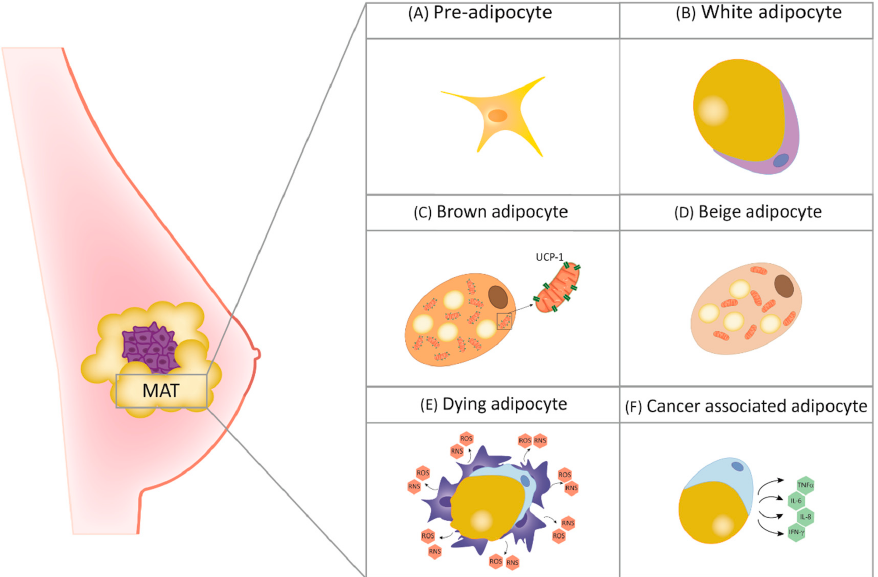
Figure 1. Typical mammary adipose tissue (MAT) cellular composition. ( A ) Pre-adipocytes, immature precursor of mature adipocytes; ( B ) white adipocytes, with lipid-storage and endocrine